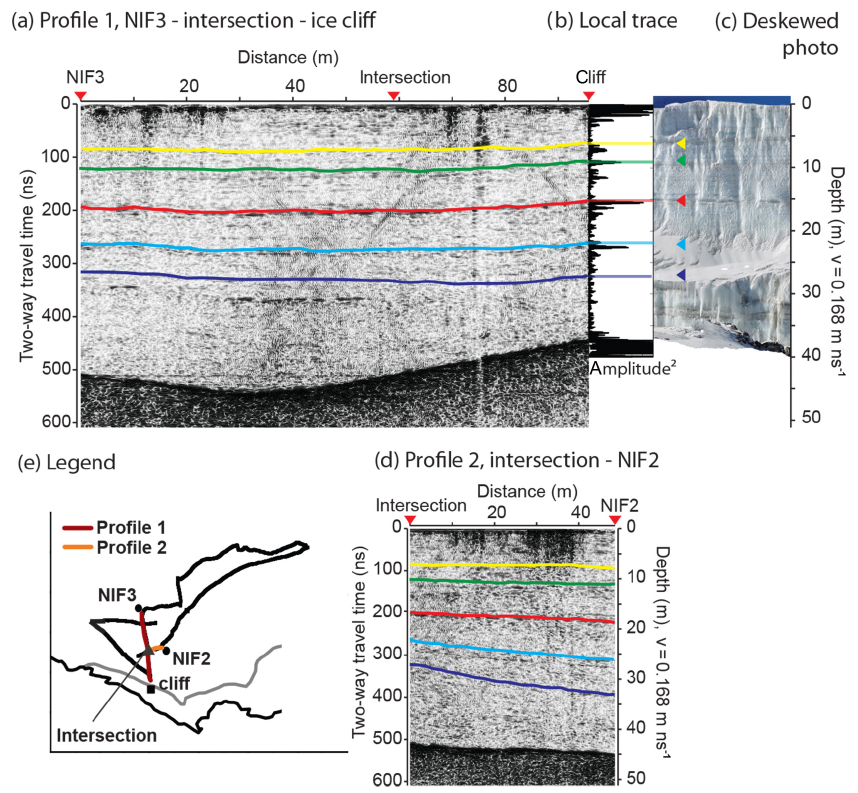
Figure 4. Direct comparison of processed GPR profiles with visible stratigraphy at the vertical wall. The location of the two GPR profiles is shown in (e) . Profile 1 extends to about 1m before the ice cliff. Top row: comparison with the full GPR profile (a) . A local trace was extracted by averaging over 2m at the end of profile 1 (b) and compared to a deskewed photo of the vertical wall (c) . Note the reflection hyperbola of an open crevasse around 78m in the profile. The colour-coded lines indicate manually picked internal reflectors, named IRH 1–5 and discussed in the